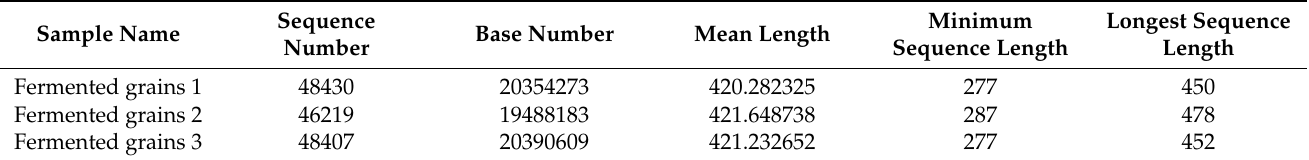
Table 2. Bacterial amplicon sequencing sample information